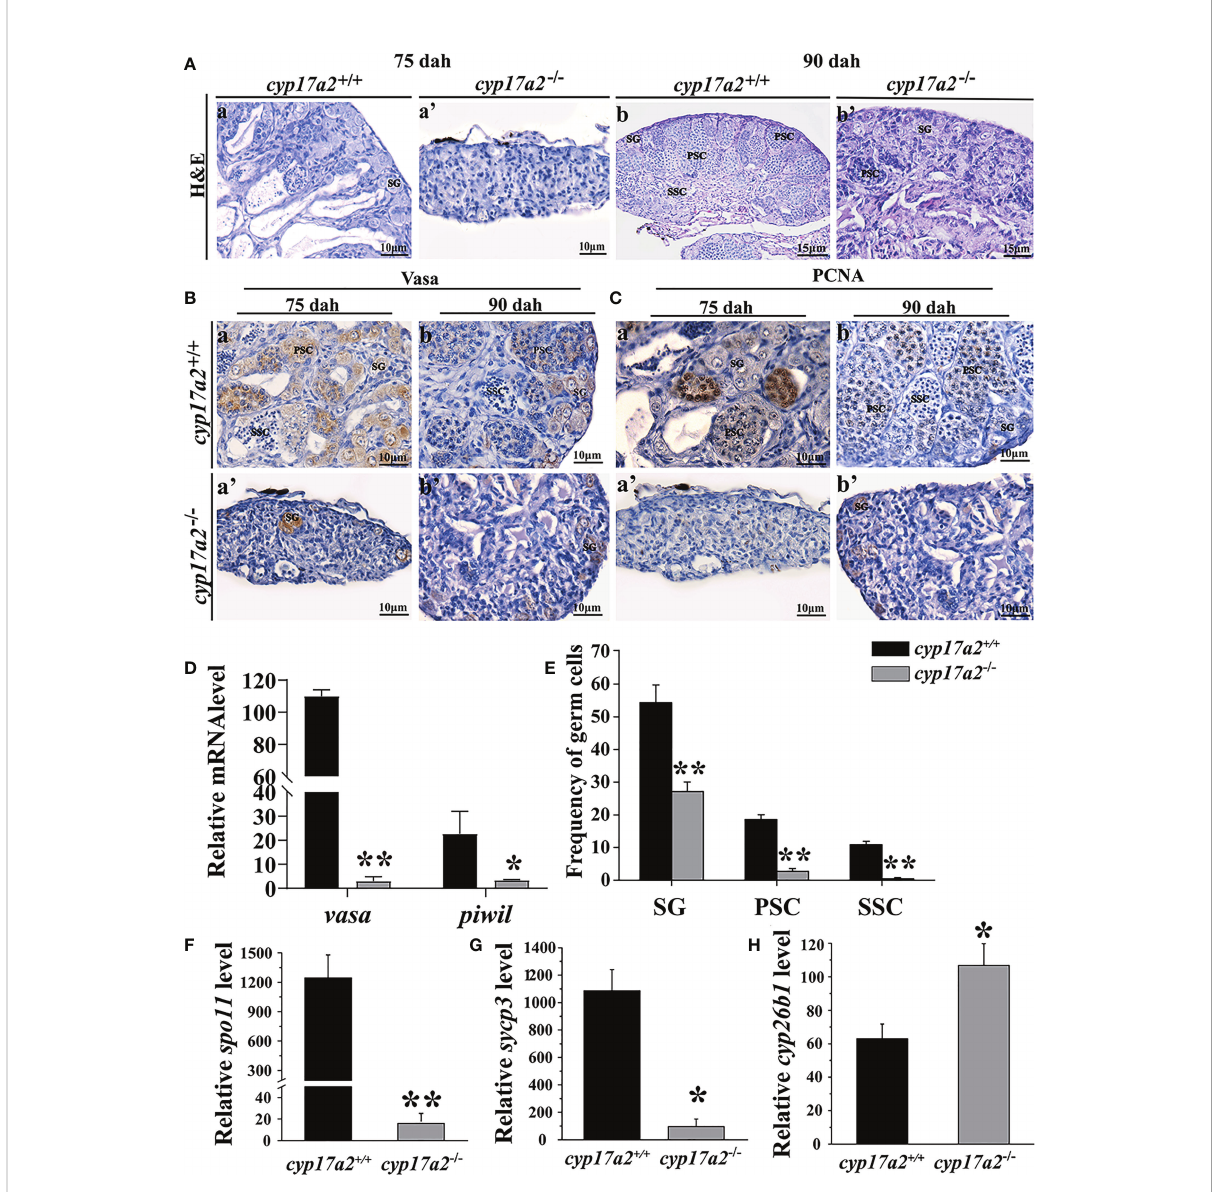
FIGURE 6 Mutation of cyp17a2 resulted in delayed spermatogenesis. (A) , H&E staining of testis from cyp17a2 +/+ (a and b) and cyp17a2 -/- XY fi sh (a ’ and b ’ ) at 75 and 90 dah. B and C, Immunohistochemistry of Vasa (B) and PCNA (C) in the testis of cyp17a2 +/+ and cyp17a2 -/- XY fi sh at 75 and 90 dah. SG, spermatogonia; PSC, primary spermatocytes; SSC, secondary spermatocytes; ST, Spermatids. (D) , Expression level of vasa and piwil in the testis of cyp17a2 +/+ (n=3) and cyp17a2 -/- (n=3) fi sh at 90 dah detected by qRT-PCR. b -actin was used as a reference gene to normalize the expression values. (E) , Spermatogenic cell proportion of cyp17a2 +/+ (n=3) and cyp17a2 -/- (n=3) XY fi sh at 90 dah. (F-H) , Expression level of spo11 , sycp3 , and cyp26b1 in the testis of cyp17a2 +/+ (n=3) and cyp17a2 -/- (n=3) fi sh at 90 dah. b -actin was used as a reference gene to normalize the expression values. The data are reported as the means±SD. Asterisk above the error bar indicate signi fi cant differences between groups tested by Student ’ s t -test (*, P<0.05; **,